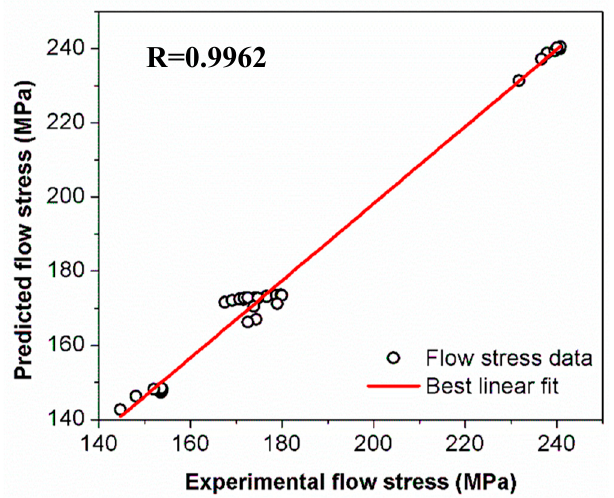
Figure 10. The proximity of experimental and predicted values by the modified Johnson–Cook model.